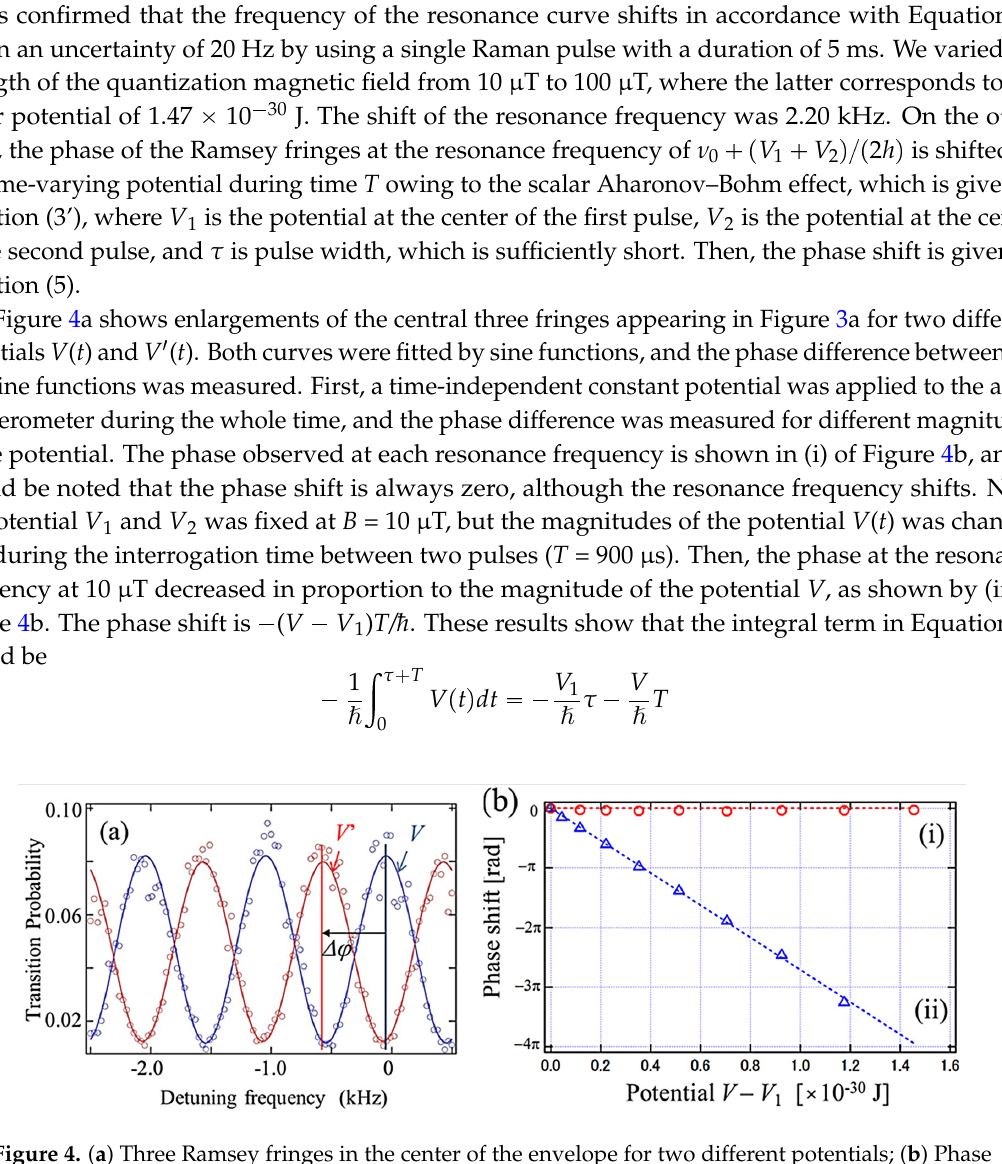
Figure 4. ( a ) Three Ramsey fringes in the center of the envelope for two different potentials; ( b ) Phase shift for two potentials (i) and